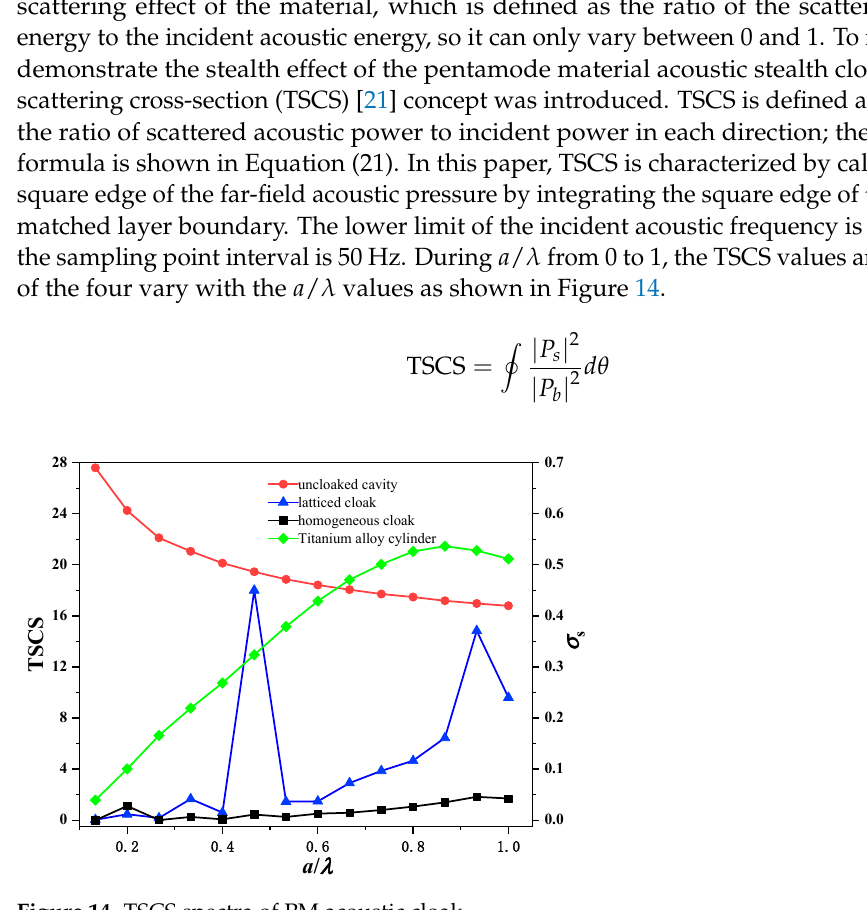
Figure 14. TSCS spectra of PM acoustic cloak. The red wire corresponds to the unpaved cloak cavity, the blue wire corresponds